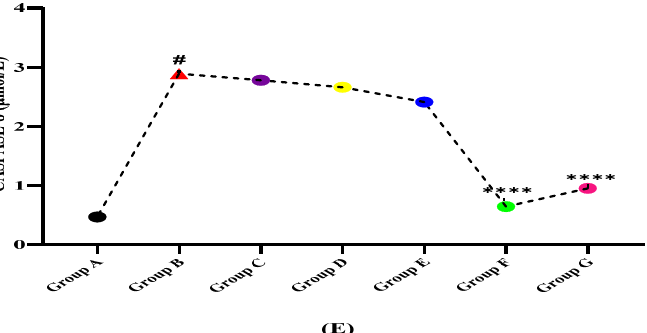
Figure 5. Comparison of plant extracts treated groups independently against LPS induced multiple sclerotic Wistar rats ( A ) CANP, ( B ) p38, ( C ) PAD-2, ( D ) COX-2, and ( E ) caspase-8. (# indicate reference group EAE model while Asterisks are showing the significance in the improvement of results as compared to reference group B). (*) slight significance, (**) moderate significance, (***) high significance, (****) very highly/effective significance. Table 5. Signaling Profile Of LPS Induced Multiple Sclerotic Wistar Rats.